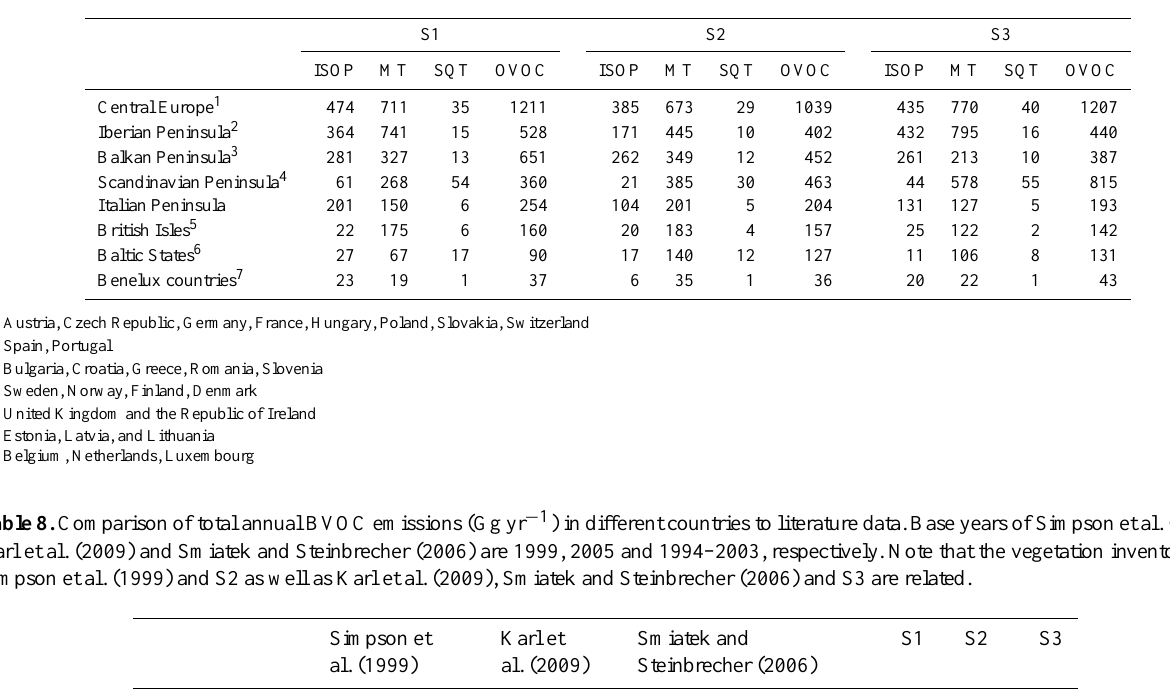
Table 7. Annual total emissions in Gg yr − 1 in selected regions of Europe for 2006, ordered by total BVOC emissions projected by S1 (common countries).